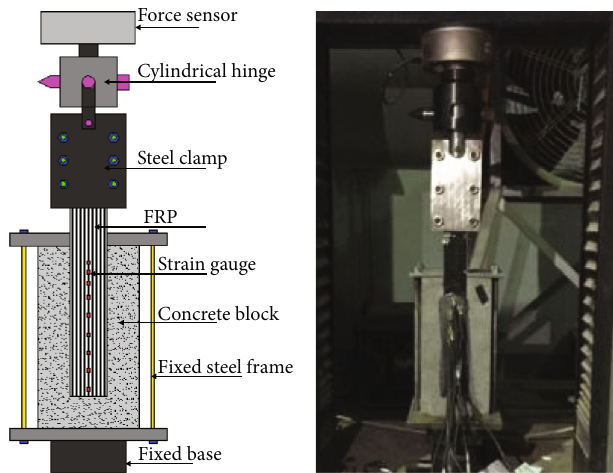
Figure 2: Loading device of single-lap shear test. Table 4: Test program and results.